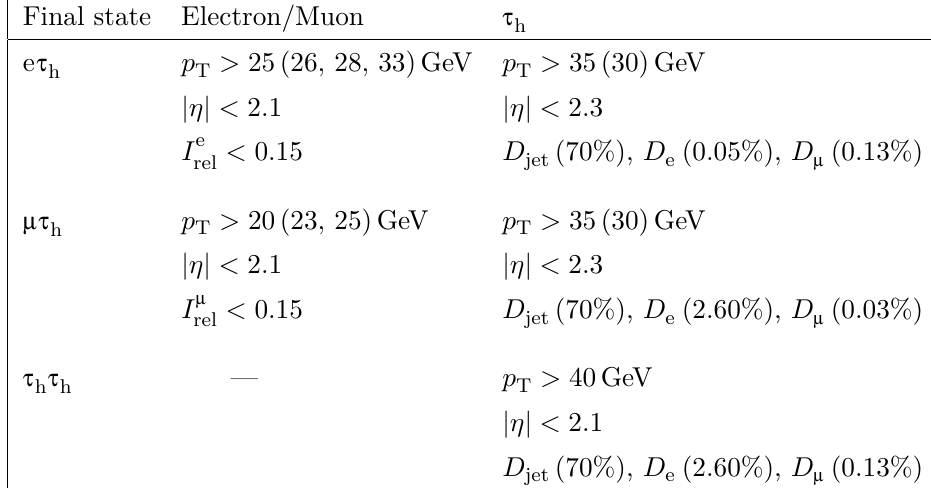
candidates used for the selection h the efficiency jet